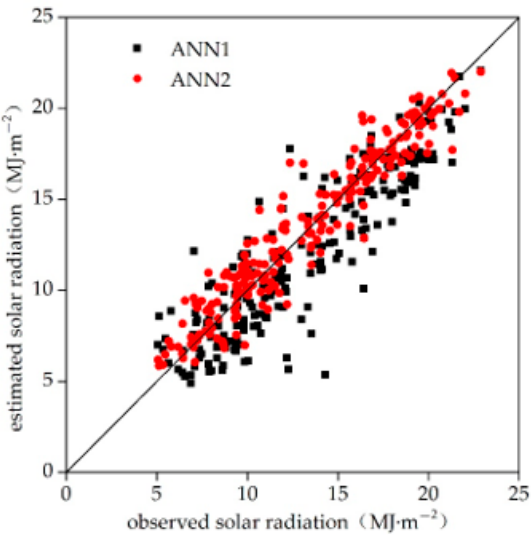
Figure 4. Scatter plot of estimated solar radiation and observations. ANN1 indicates the input parameters of P, T, Pw, RH and S 0 . ANN2 indicates that the input parameters of P, T, Pw, RH, S 0 , AOT, CF, COT and